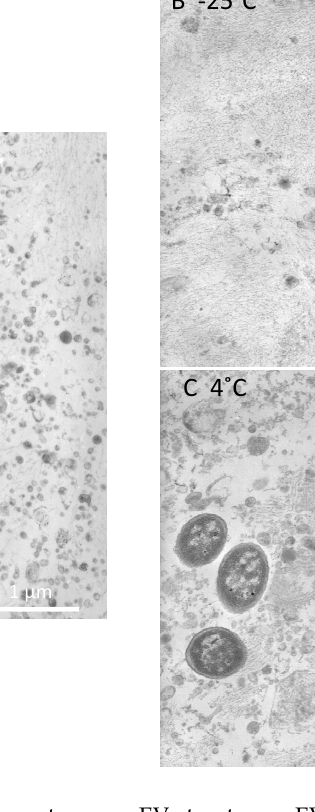
Figure 2. Effects of storage temperatures on EV structures. EV samples were stored at 4, − 25, or − 80 ◦ C for 1 week, and prepared for EM observation. ( A ) Abundant small vesicles were observed in the specimen stored at − 80 ◦ C; ( B ) few vesicle structures were observed in the specimens stored at − 25 ◦ C; ( C ) the specimens stored at 4 ◦ C showed fewer vesicles, some of which appeared to be